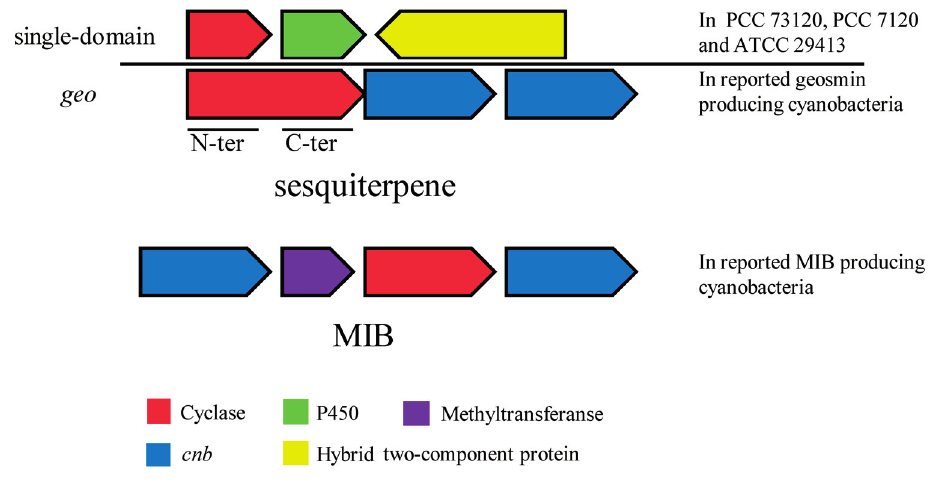
Figure 6. Clustering of cyanobacterial geo , single-domain sesquiterpene gene and MIB-synthesis-associated open reading